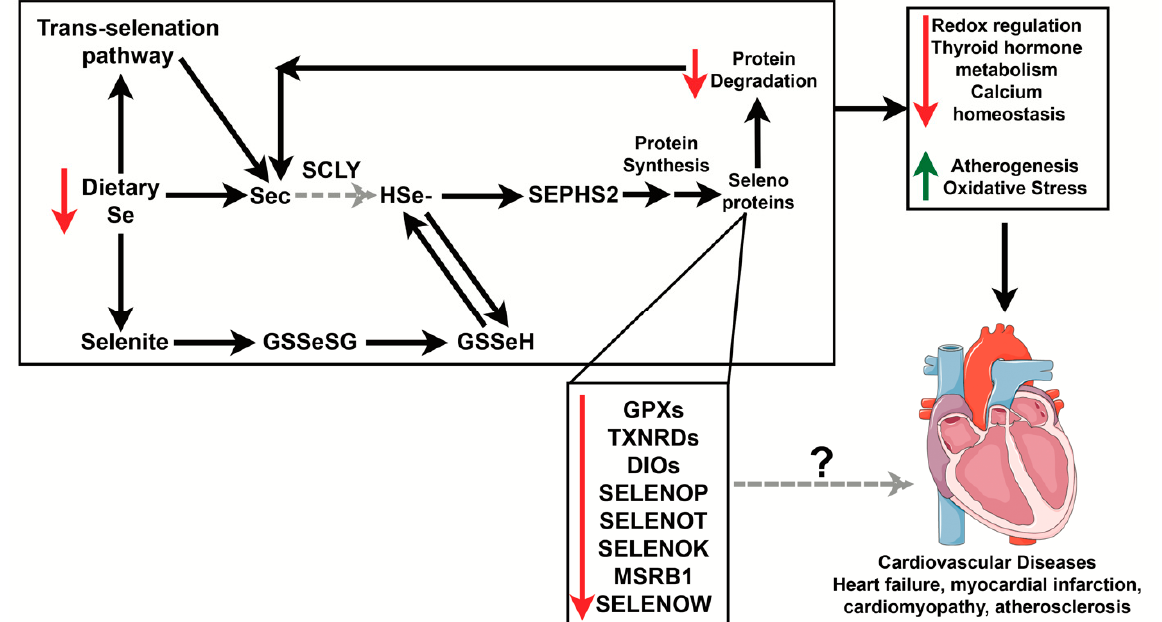
Figure 1. Potential mechanism of how Se deficiency impacts Se metabolism and contributes to cardiovascular diseases. Se acquired through the diet can go through the trans-selenation pathway and be directly converted to Sec, becoming hydrogen selenide. In cases of low Se, stress-responsive selenoprotein synthesis may be affected. Those selenoproteins with known function in the heart are shown above but it is still unknown how some of these proteins contribute to the development of cardiovascular disease in cases of Se deficiency. Decreased levels of Se may negatively impact redox regulation, thyroid hormone metabolism, and calcium flux while increasing atherogenesis and oxidative stress. This, in turn, may lead to several cardiovascular diseases, including heart failure, myocardial infarction, cardiomyopathy, and atherosclerosis. Red arrows indicate processes and proteins that are decreased while green arrows indicate processes that are increased during Se deficiency. Black arrows point to known relationships, and dashed gray lines indicate the relationships that have not been established yet in the heart. The “?” indicates mechanisms that have not been determined. Se, selenium; Sec, selenocysteine; HSe–, hydrogen selenide; SEPHS2, selenophosphate synthetase 2; GPX, glutathione peroxidase; TXNRDs, thioredoxin reductases; DIO, iodothyronine deiodinases; SELENOP, selenoprotein P; SELENOT, selenoprotein T; SELENOK, selenoprotein K; MSRB1, methionine sulfoxide reductase B1; SELENOW, selenoprotein W. Heart was used from Servier Medical Art (smart.servier.com).